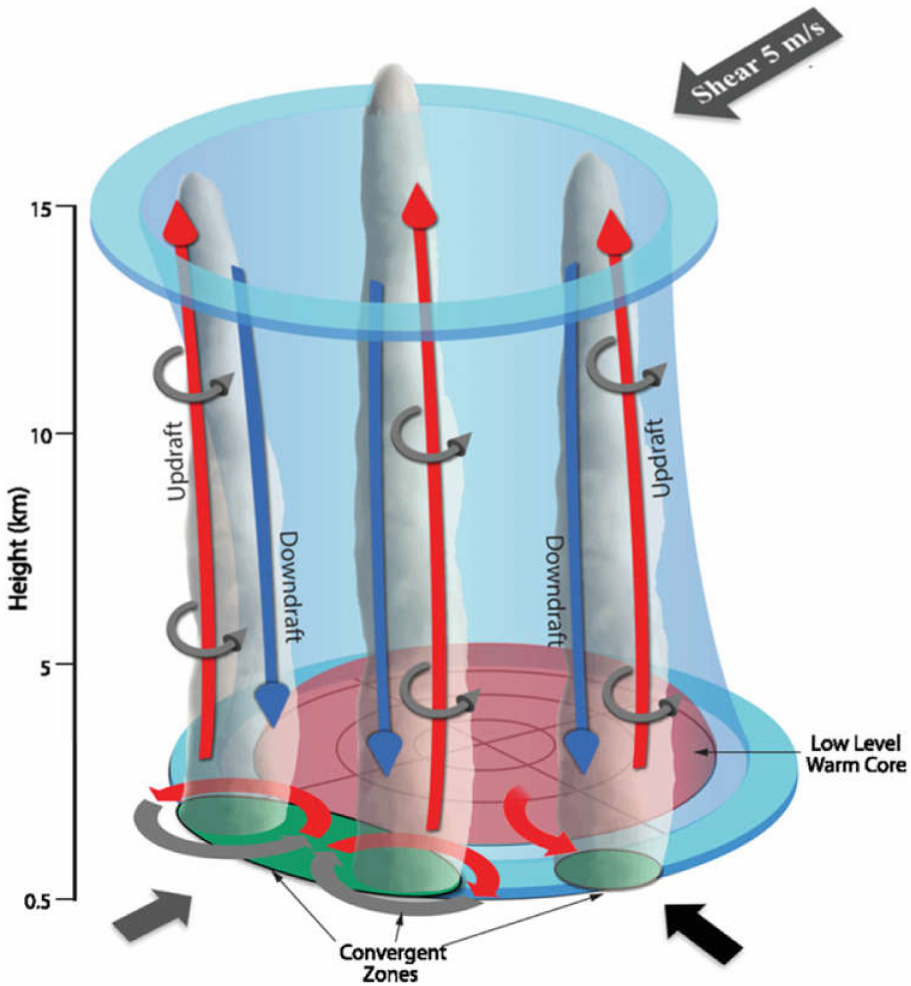
Figure 11. Conceptual diagram highlighting the measurements and analysis from the HIWRAP, HAMSR, and WP-3D TDR during the Hurricane Karl (2010) sampling. The arrows at lower levels represent the mesoscale flow and the arrows in the clouds represent the convective-scale flow. Red arrows indicate anomalously warm, buoyant air with blue arrows the opposite. Adapted from